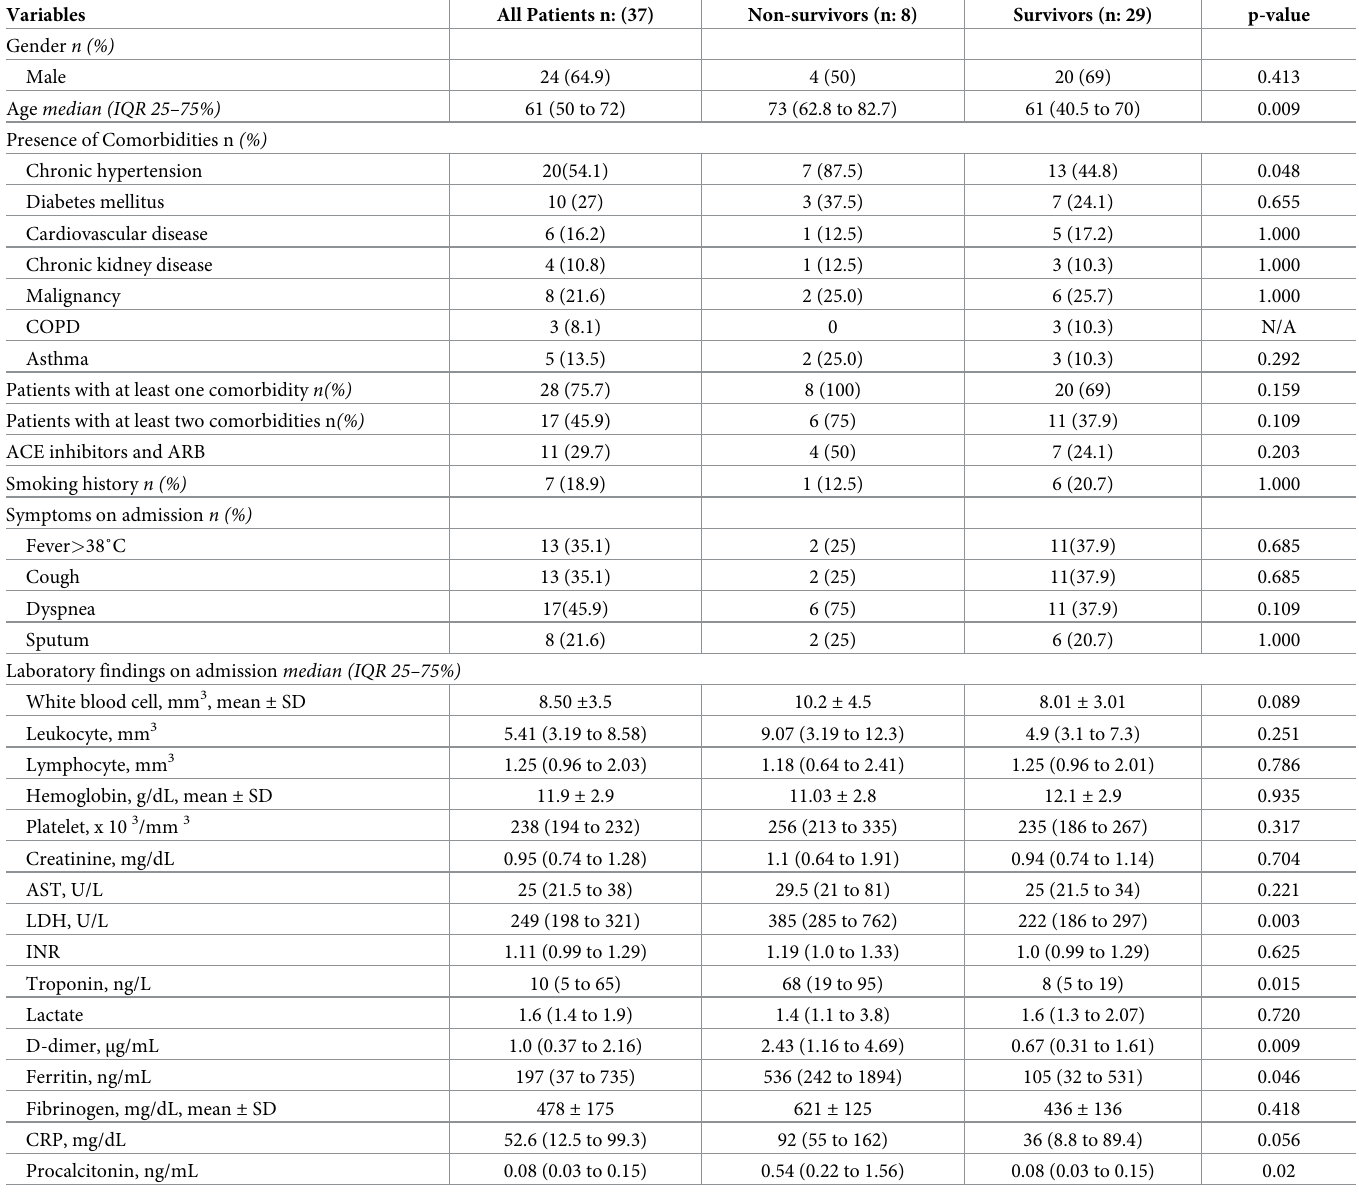
Table 1. Demographical and clinical characteristics of patients according to